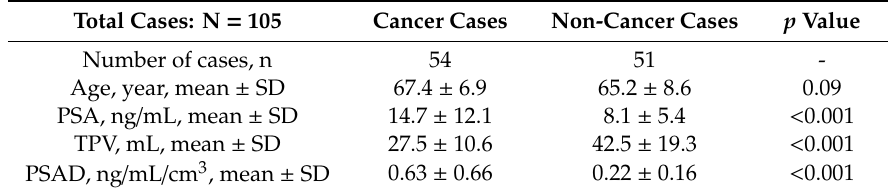
Table 1. Patient characteristics PSA = Prostate-specific antigen, TPV = Total prostate volume, PSAD = PSA density, SD = Standard deviation.